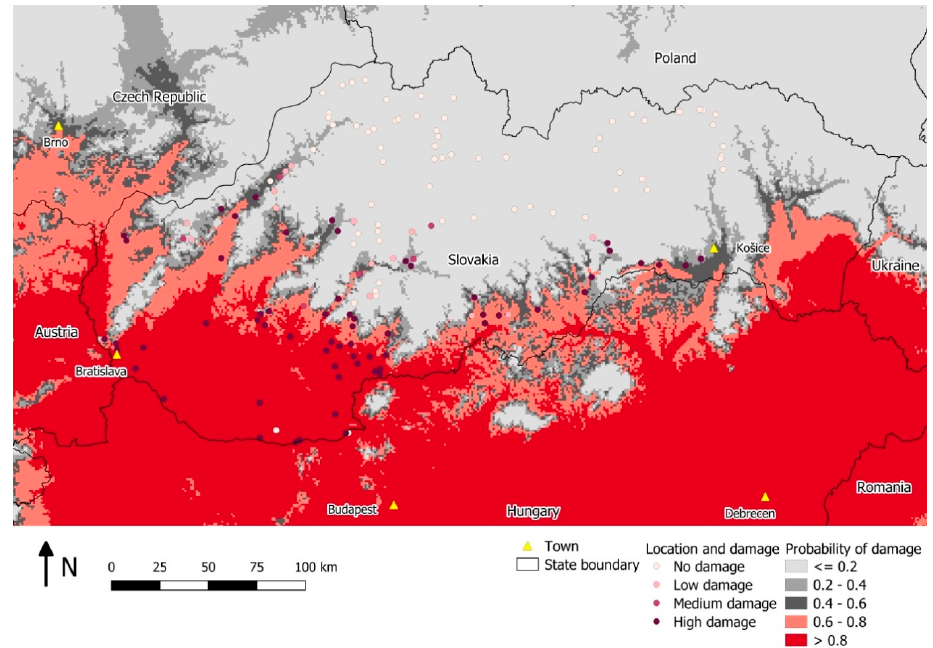
Figure 4. Map of Slovakia and surrounding regions showing the probability of high damage to box trees by Cydalima perspectalis predicted by mean annual temperature.